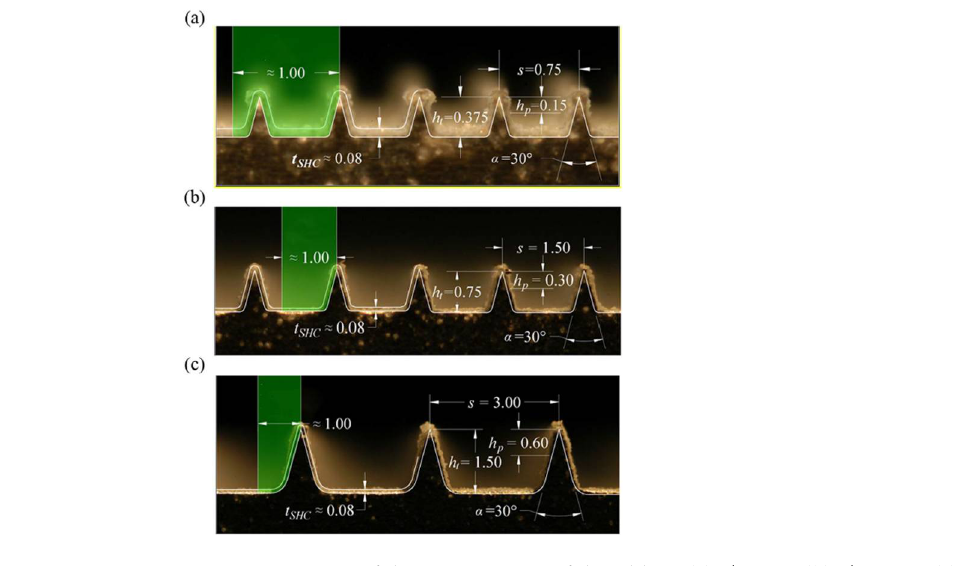
Figure 19. Images of the cross-section of the riblets. ( a ) s + = 8.6; ( b ) s + = 17.3; ( c ) s + = 34.6. Reprinted with permission from Ref [100]. Copyright 2018 Elsevier.